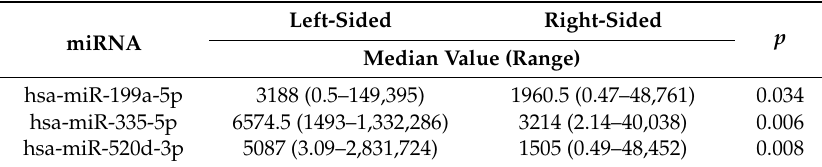
Table 2. miRNAs significantly correlated with tumor localization.